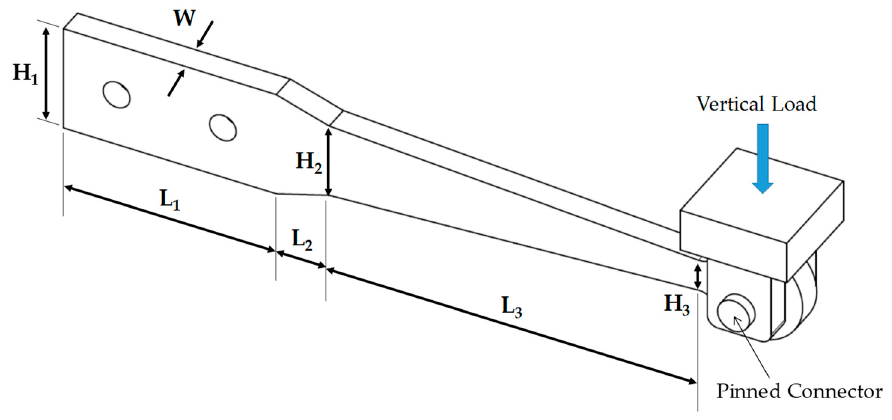
Figure 11. Configurations and dimensional parameters of steel damper.